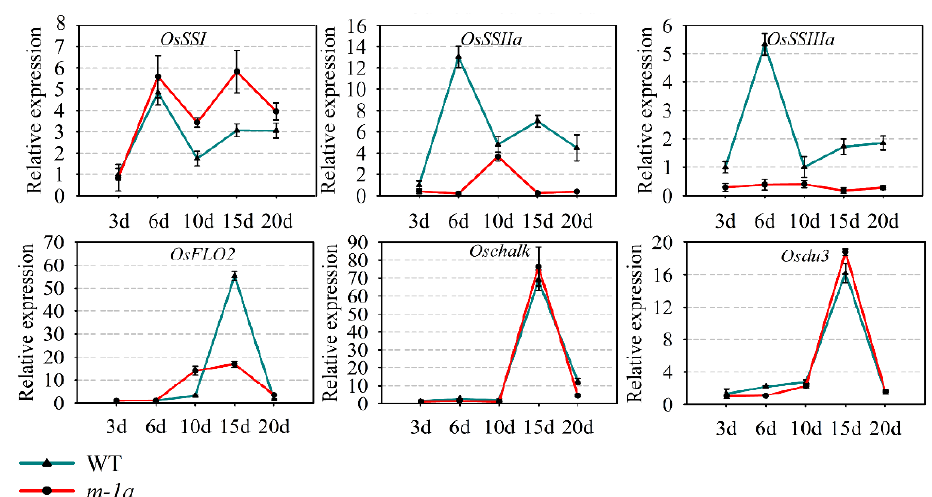
Figure 7. Expression profiles of 18 rice starch synthesis genes during development of Zhonghua 11 (wild-type) and the m-1a strain. The gene expression in the 3-d endosperm of wild-type rice was used as a control. d = days after pollination; WT = wild type. Values represent the mean ± SD of triplicates.